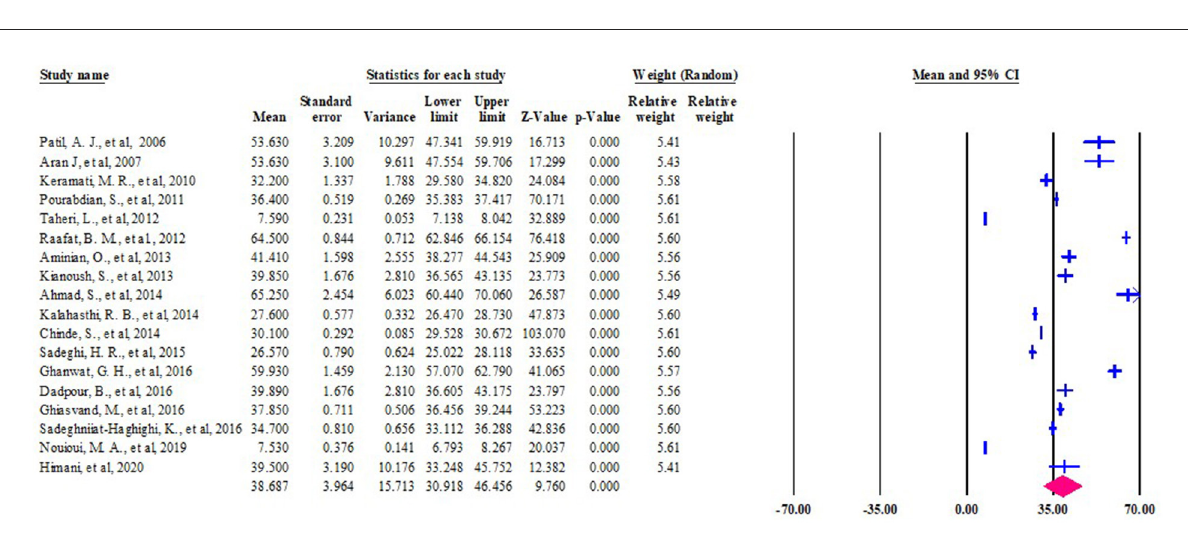
FIGURE6 Forest plot of the pooled mean of BLL among lead battery workers in LMIC, 2022 ( n = 18).